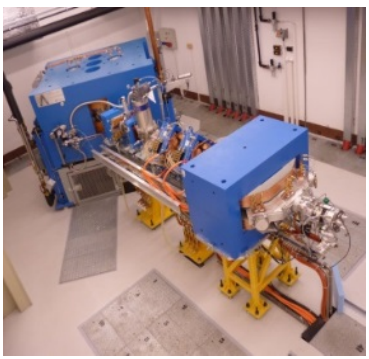
Fig. 1. The TR-24 cyclotron of the Nuclear Physics Institute,